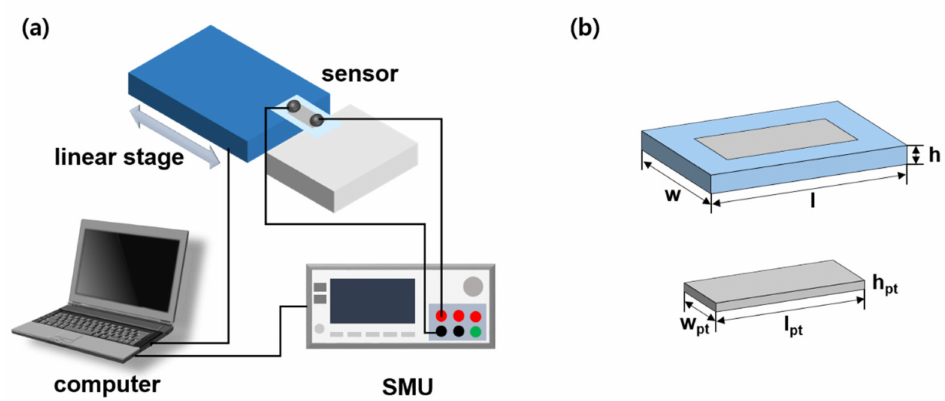
Figure 2. ( a ) Schematic of the sensor-evaluating system. ( b ) Schematic of the